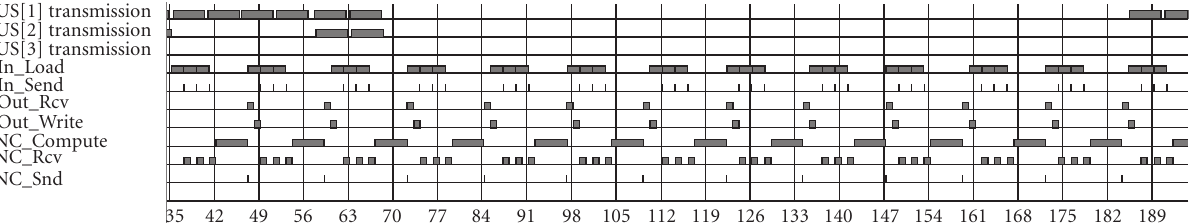
Figure 9: Gantt diagram generated by the system simulator.